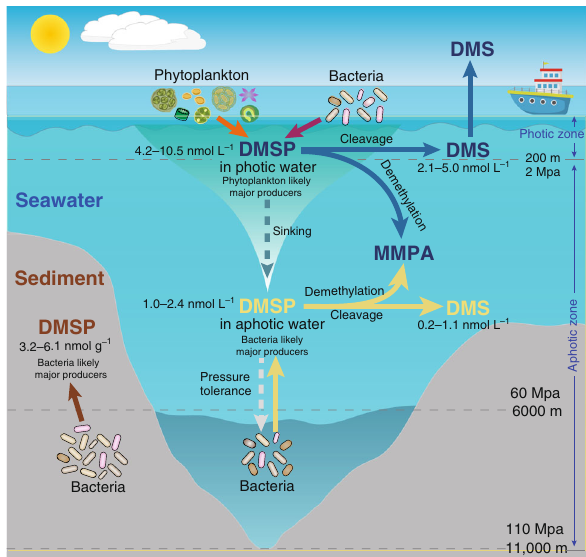
Fig. 4 The proposed cycling of DMSP throughout the water column. Phytoplankton are the major contributors to DMSP production in the photic zone, whereas in aphotic zones, where no sunlight penetrates, heterotrophic bacteria likely contribute signi fi cantly to DMSP production. DMSP produced in the surface waters can sink to lower levels. Sedimentary DMSP levels are two to three orders of magnitude higher, per equivalent mass, than the seawater, and are also most likely produced by bacteria. The relative abundance of DMSP catabolic genes was lowest in the deepest water and sediment samples, and DMSP can play a role in protecting bacteria against increased hydrostatic pressure in such deep waters and sediment. DMSP and DMS produced in the surface water is labeled in blue. Deep-ocean DMSP and DMS is in yellow and sedimentary DMSP is labeled in brown. Values in this fi gure represent DMSP or DMS concentration ranges determined by this